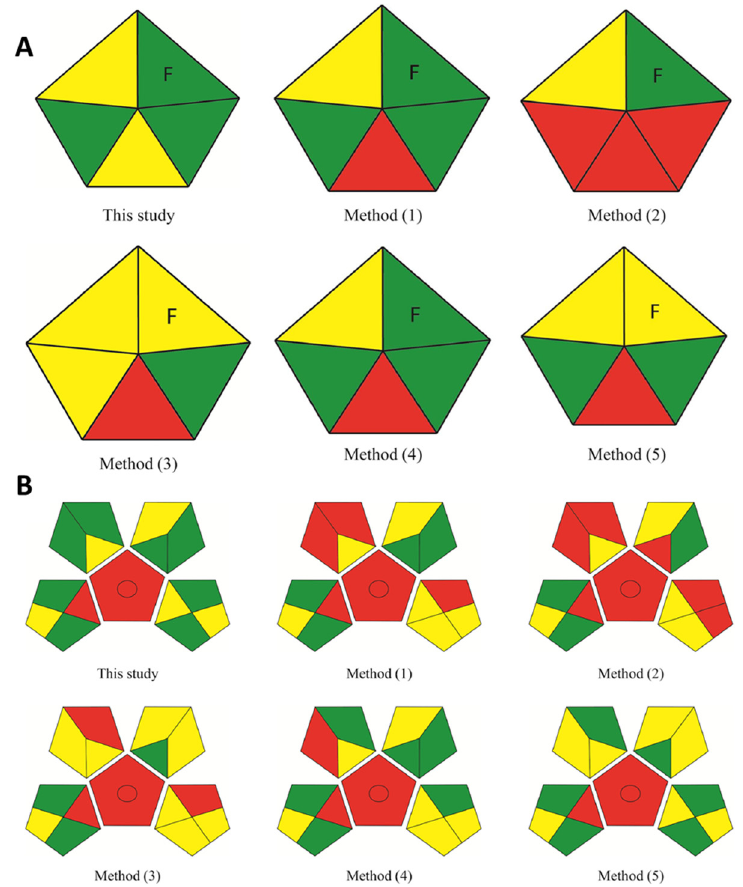
Figure 1. Greenness assessment of the developed and other reported DLLME methods for the determination of EDCs by Raynie ( A ) and GAPI ( B ) pictograms. Reprinted from El-Deen, A. K.; Shimizu, K. A Green Air Assisted-Dispersive Liquid-Liquid Microextraction Based on Solidification of a Novel Low Viscous Ternary Deep Eutectic Solvent for the Enrichment of Endocrine Disrupting Compounds from Water. J. Chromatogr. A, 2020, 1629, 461498 with permission from Elsevier